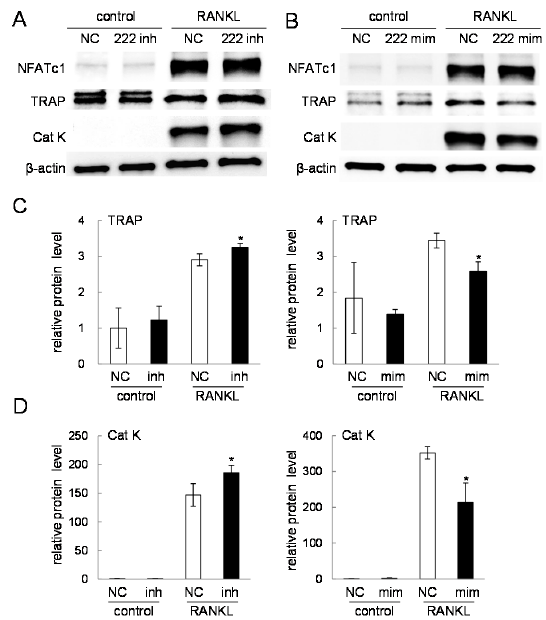
Figure 5. Western blot analysis of NFATc1, TRAP, and cathepsin K in response to the inhibitor or mimic specific to miR-222-3p. Of note, 50 ng/mL RANKL was used for three days in all cases. The sample number was three in ( C , D ). NC = non-specific control; inh = inhibitor; and mim = mimicking agent. The single asterisk indicates p < 0.05. ( A ) Expression of NFATc1, TRAP, and cathepsin K in response to the inhibitor of miR-222-3p; ( B ) Expression of NFATc1, TRAP, and cathepsin K in response to the mimic of miR-222-3p; and ( C , D ) Quantified expression levels of TRAP and cathepsin K, respectively, in response to the inhibitor and mimic of miR-222-3p.